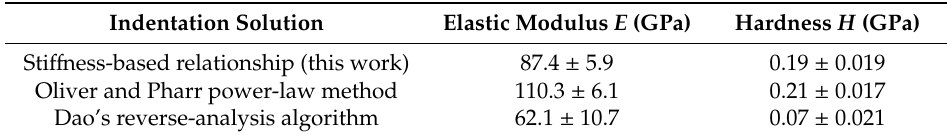
methods. Table 2. Bulk aluminum properties using proposed stiffness-based solution and other conventional